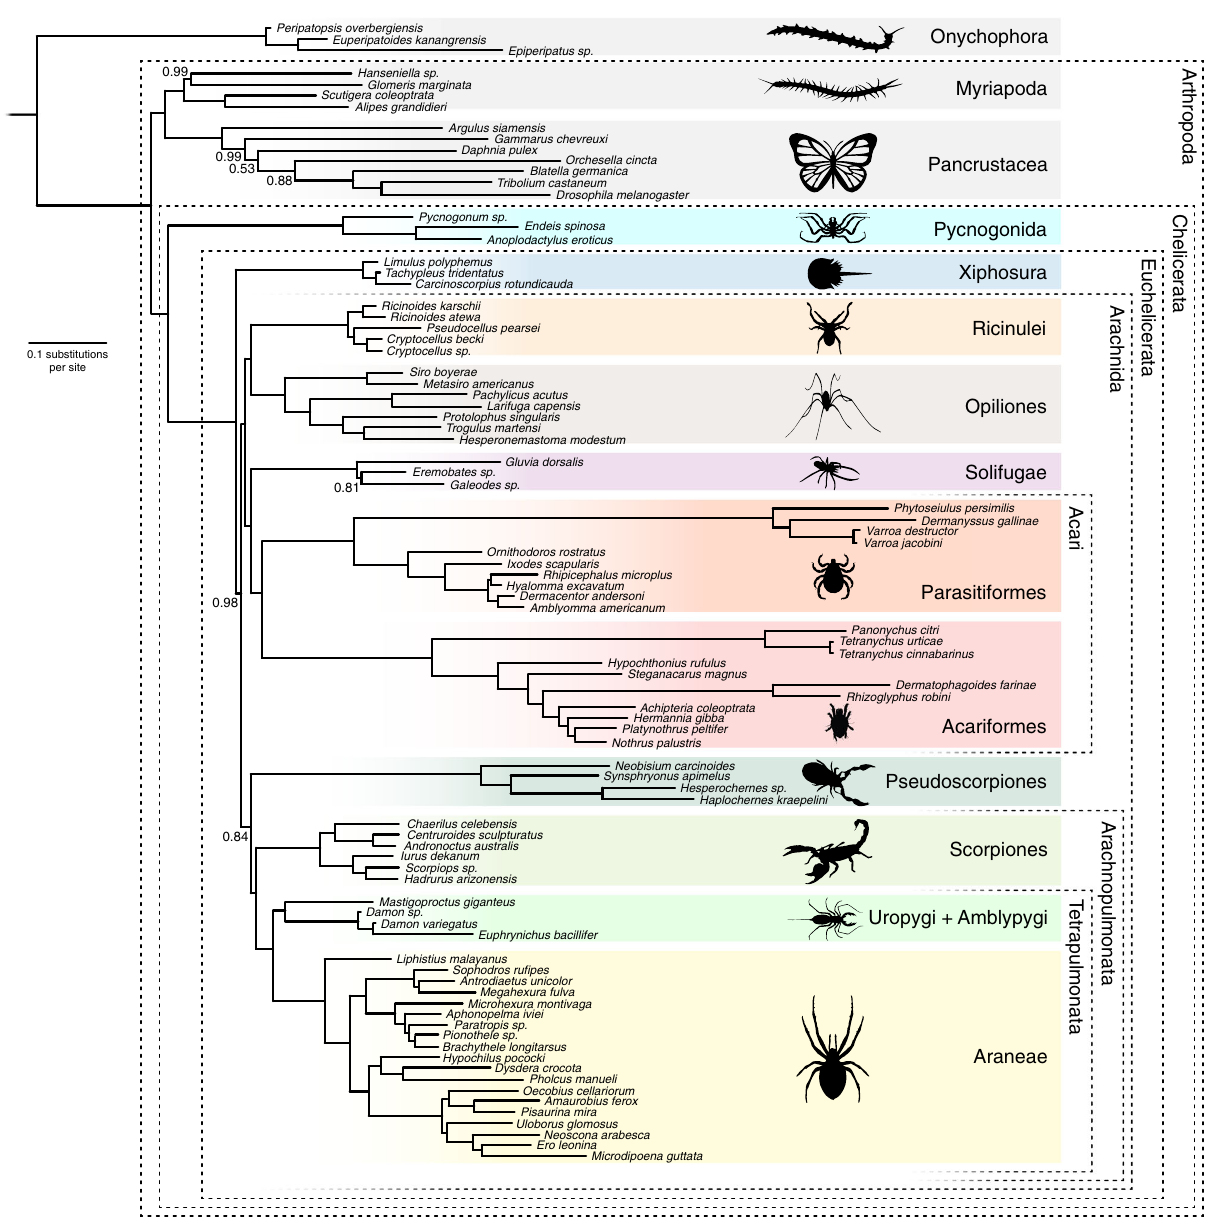
Fig. 2 Phylogenetic tree derived from the CAT-GTR + G analyses of Matrix A after exclusion of six unstable taxa ( Calanus , Bothriurus, Liocheles, Pandinus, Superstitionia and Vietbocap ). Removal of unstable taxa did not affect topological relationships but increased support levels at key nodes and improved convergence statistics. Support values represent posterior probabilities. Convergence statistics: Burnin = 3000; Total Cycles = 10,000 subsampling frequency = 20. Maxdif = 0.28; Minimal effective size = 63. Silhouettes designed by